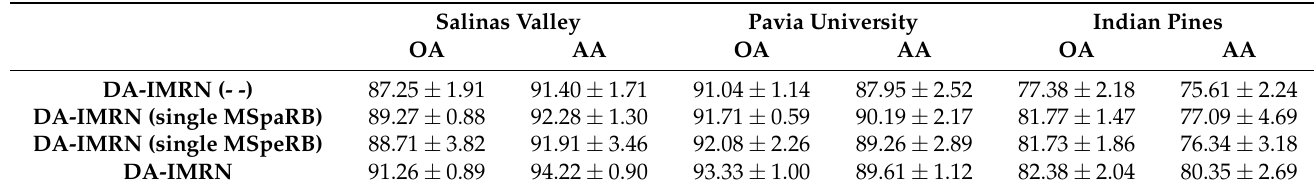
Table 8. Performance comparisons in terms of OA and AA (in %) between the networks with/without multi-scale residual blocks. DA-IMRN (- -) represents replacing both MSpaRB and MSpeRB in DA- IMRN with ordinary residual block without multi-scale convolution. DA-IMRN (single MSpaRB) (or DA-IMRN (single MSpeRB)) means that only MSpaRB (or MSpeRB) is used in the network, and another block is replaced with standard residual block.